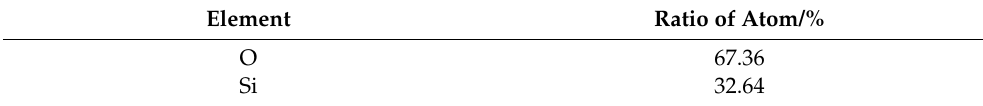
Table 2. The elemental composition of modified PUS at 750 °C.